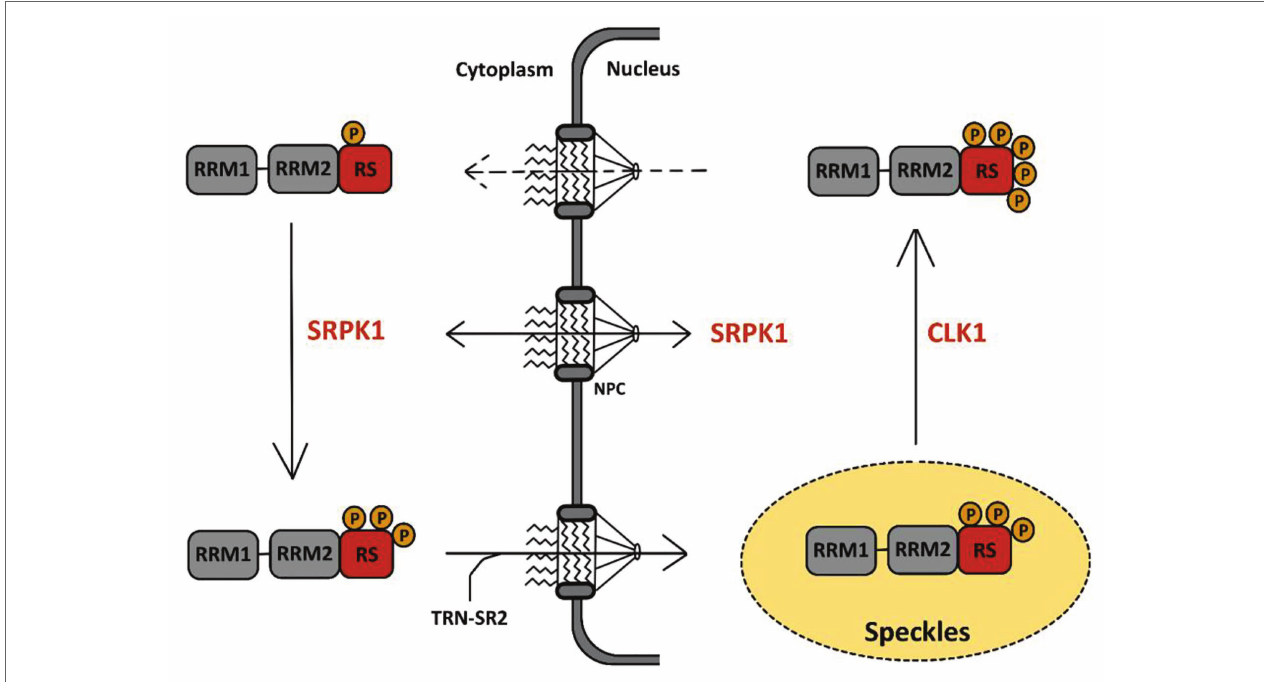
FIGURE 4 | Phosphorylation cycle of SR proteins by serine-arginine protein kinase 1 (SRPK1) and CLK1. The sequence of events leading to the phosphorylation of SR proteins by SRPK1 and CLK1 has been well-documented for SRSF1, the prototype of the SR protein family, schematically represented here with two RRM domains followed by one RS domain. A first wave of SRSF1 phosphorylation takes place in the cytoplasm via SRPK1 that targets serine residues in its RS domain. This initial event triggers SRSF1 translocation to the nucleus through the nuclear pore complex (NPC) via association with the SR-specific transportin-2 (TRN-SR2) protein. Within the nucleus, SRSF1 accumulates in nuclear speckles (in yellow) together with other RNA-binding proteins. There, CLK1 further hyper-phosphorylates SRSF1 at serine residues in the RS domain. This second event drives the egress of SRSF1 from the speckles toward the nucleoplasm where it binds to pre-mRNA and to several other splicing factors to support co-transcriptional splicing. Dephosphorylation events by phosphatases are then required to complete the splicing reaction and for nuclear egress of SRSF1 together with spliced